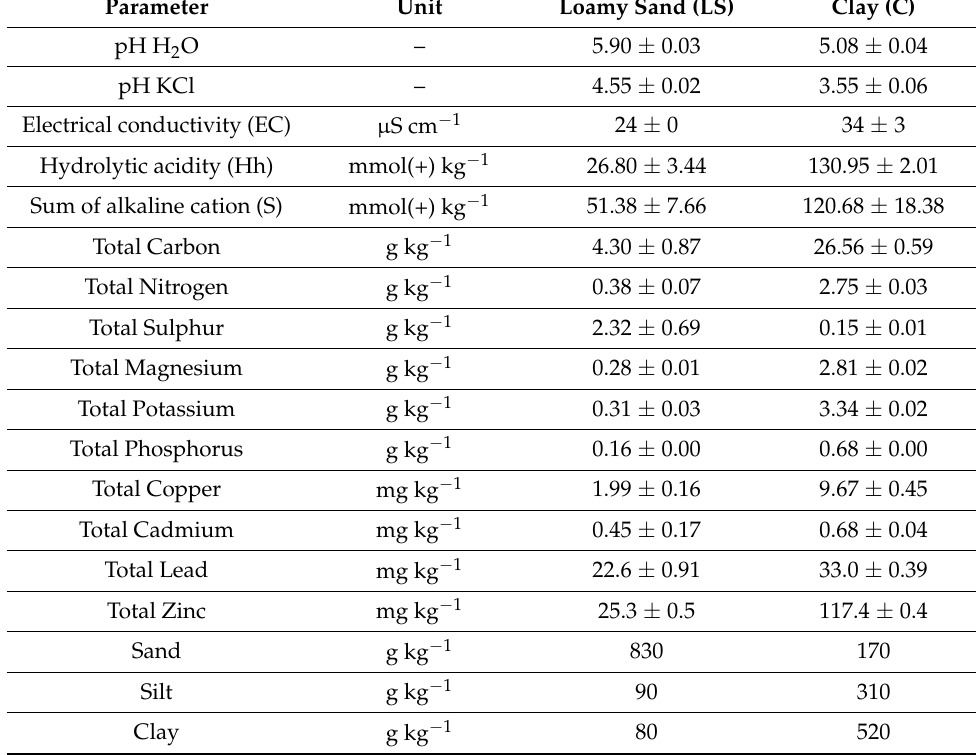
Table 2. Selected chemical and physical properties of the soil ( ± standard deviation).